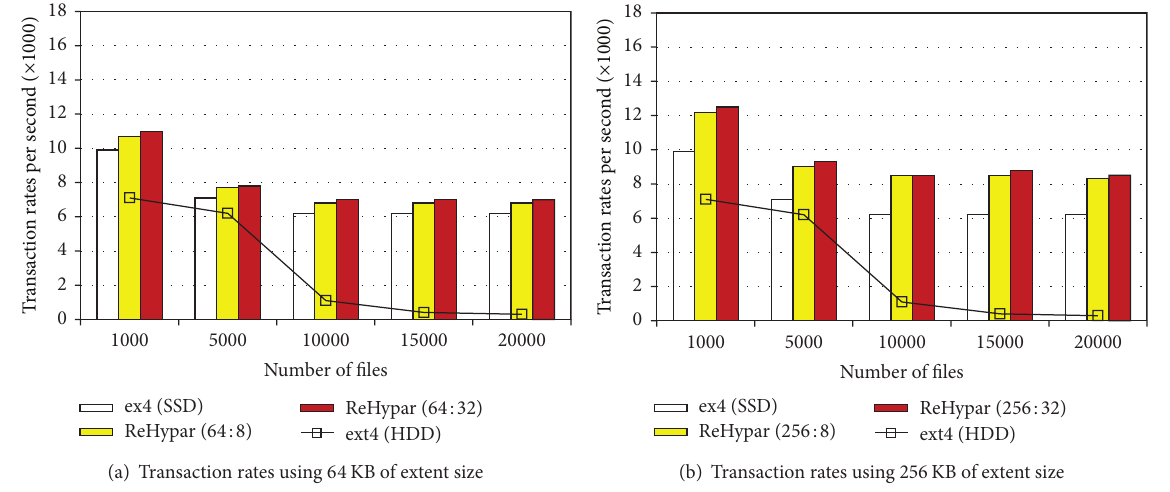
Figure 6: ReHypar transaction rates as compared to